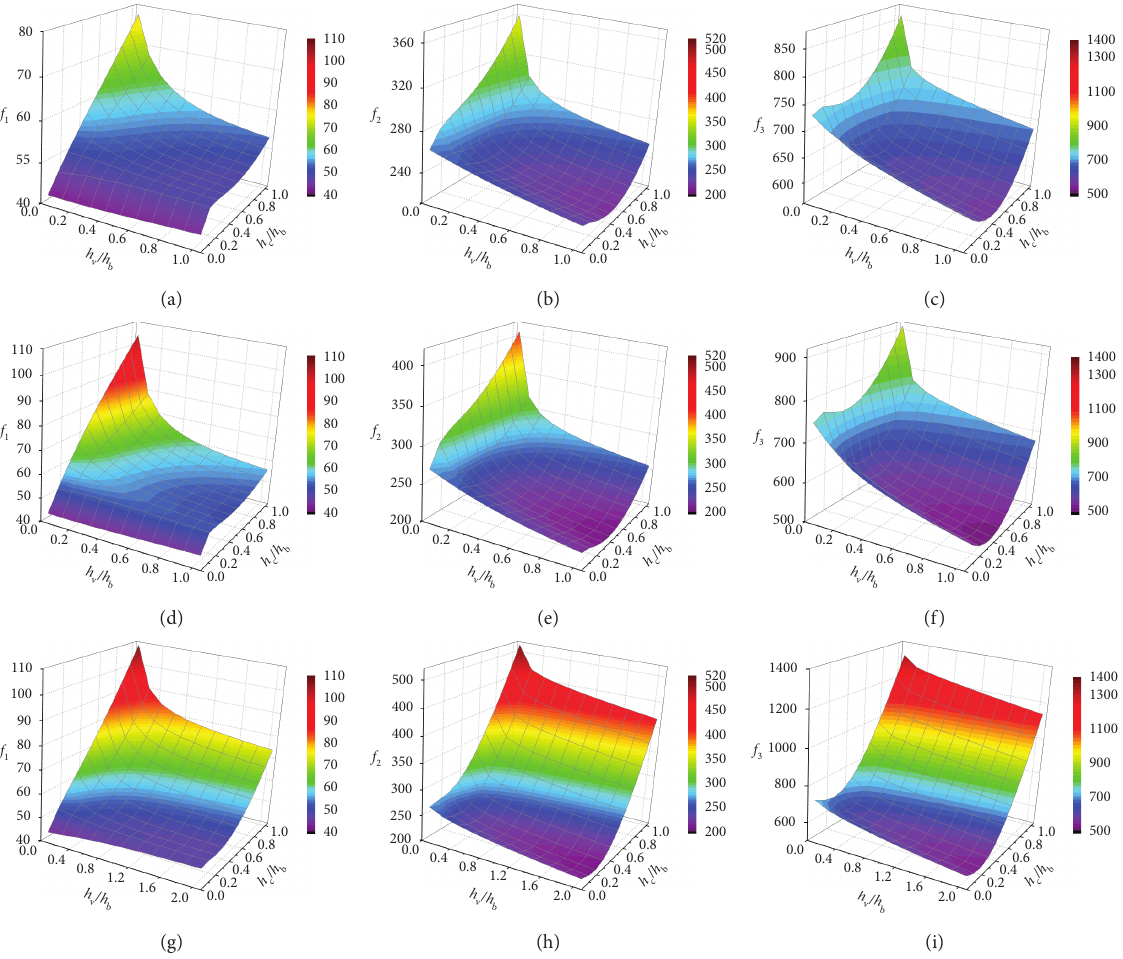
Figure 7: The parameter effects on the first three modal frequencies. (a) Mode 1 for structure 1. (b) Mode 2 for structure 1. (c) Mode 3 for structure 1. (d) Mode 1 for structure 2. (e) Mode 2 for structure 2. (f) Mode 3 for structure 2. (g) Mode 1 for structure 3. (h) Mode 2 for structure 3. (i) Mode 3 for structure